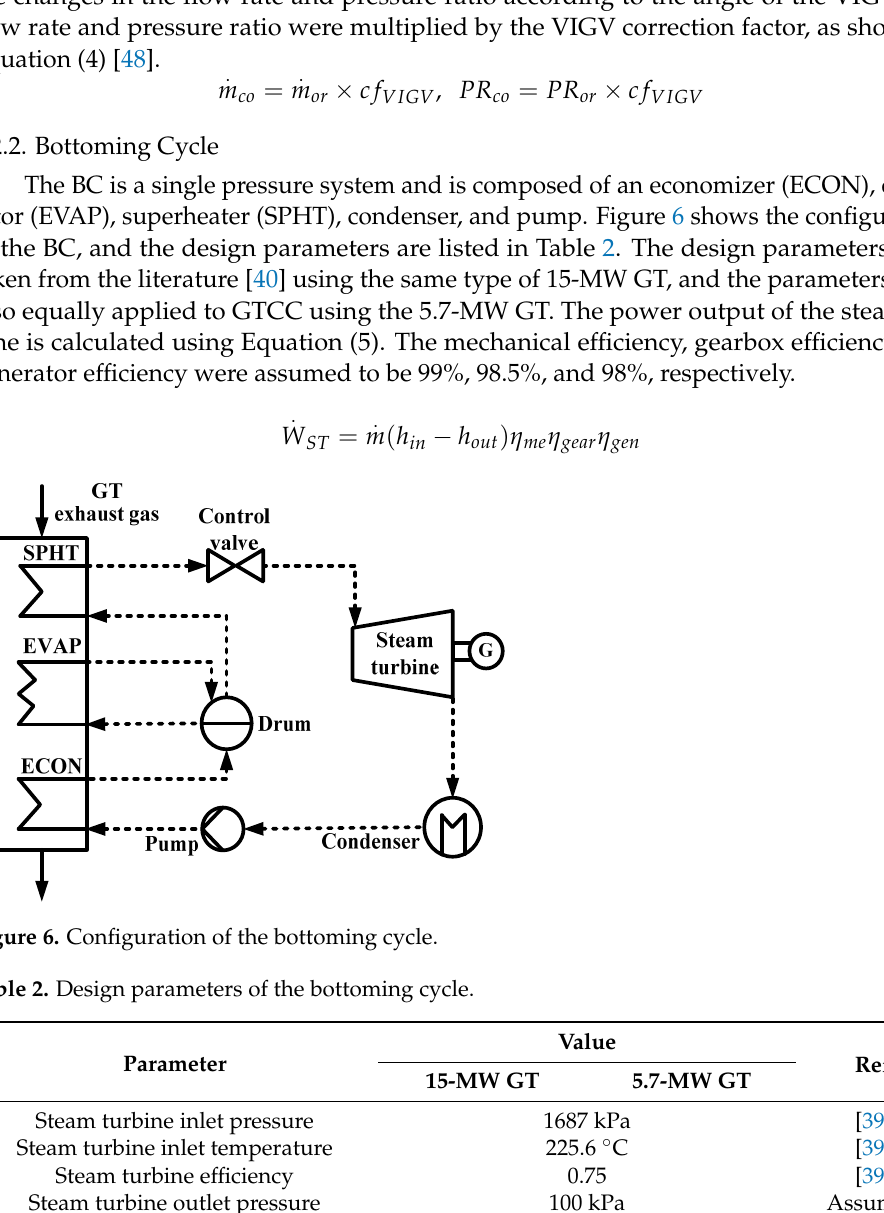
Figure 5. Normalized performance map of the gas turbine: ( a ) Compressor performance map; ( b ) Turbine performance map.